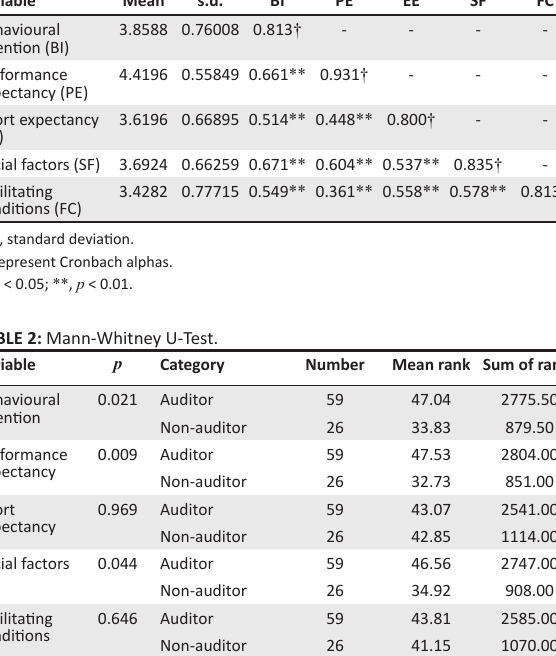
TABLE 1: Means, standard deviations, Cronbach’s alpha and correlations.